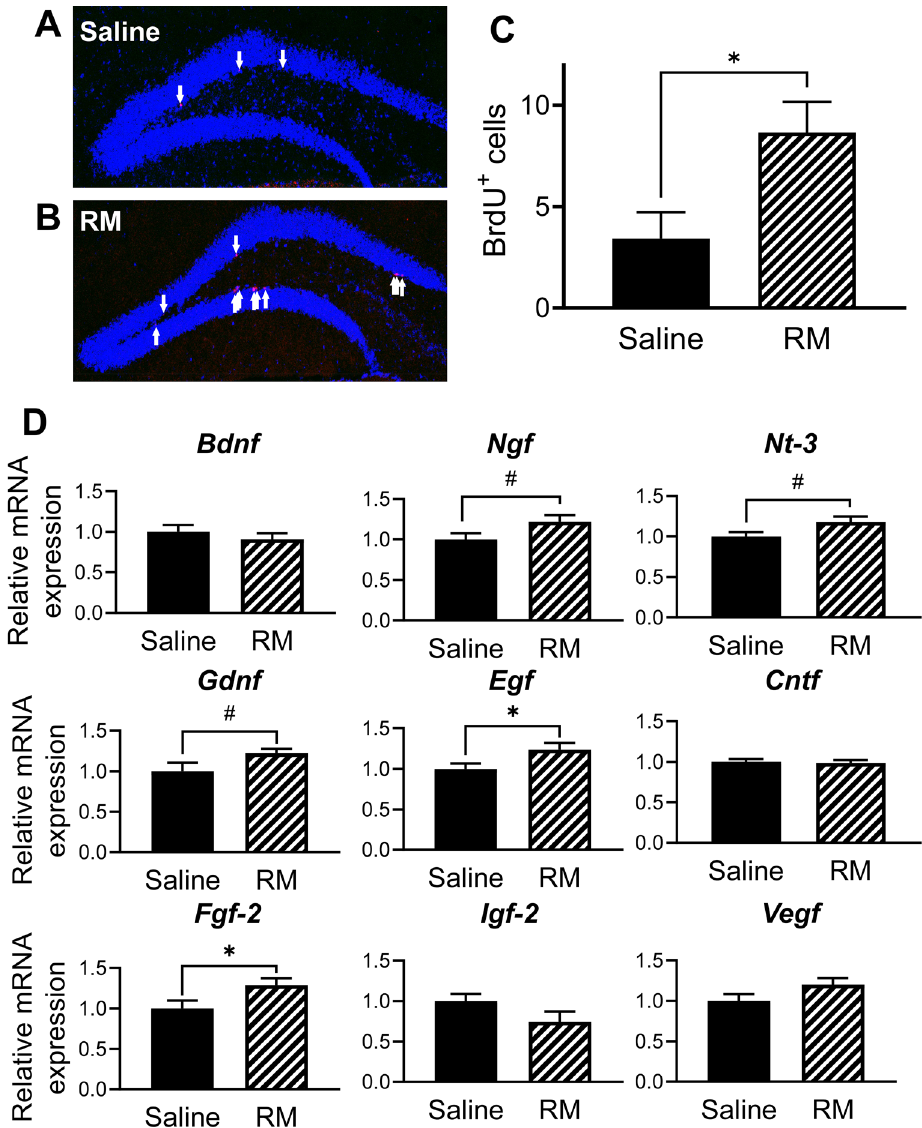
Figure 5. Rice-memolin increases hippocampal neurogenesis and mRNA expression of neurotrophic factors in mice fed with HFD. Representative histology of the mice administered ( A ) saline or ( B ) rice-memolin and ( C ) the number of BrdU-positive cells. ( D ) Changes in the hippocampal mRNA expression of neurotrophic factors. All values are means ± SEM ( A – C , n = 4; D , n = 6). # P < 0.1, * P < 0.05 vs. saline group. RM: